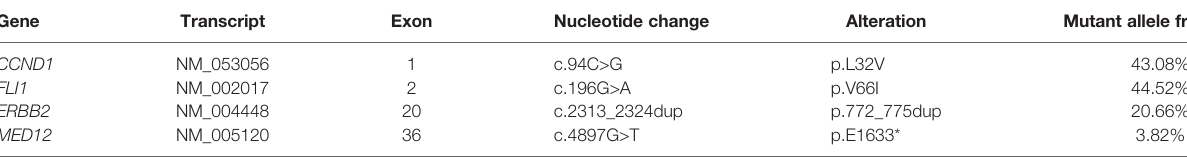
TABLE 2 | Mutation pro fi le of left lung tumor in the patient.